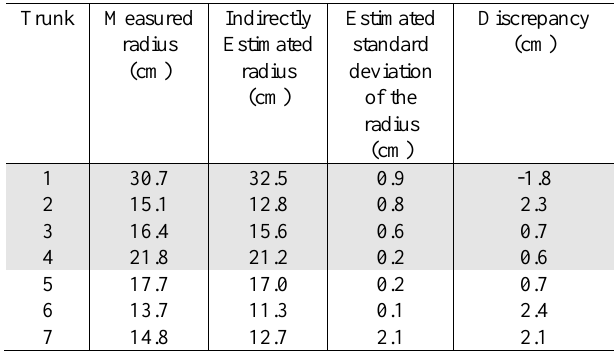
Table 2. Comparison of results considering seven trunks: indirectly estimated radius against measured radius, around 1.30 m of